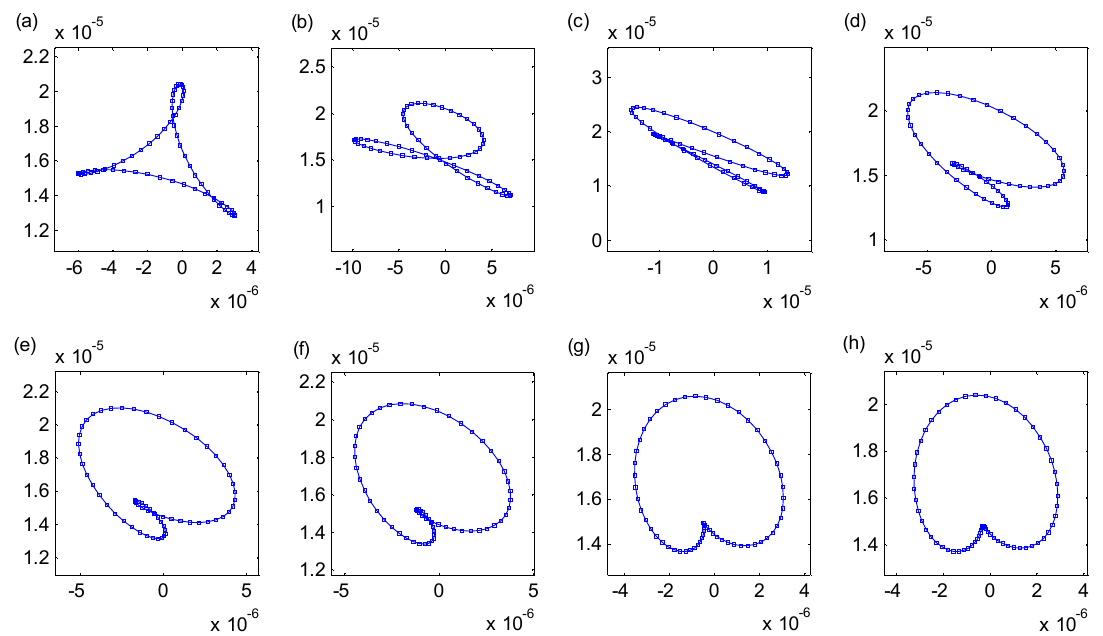
Figure 7. The evolution of orbits of the central node versus the anisotropic parameters of principle sti ff ness coe ffi cient at the speed of 3800 r / min: ( a ) α k = 0.5; ( b ) α k = 0.6; ( c ) α k = 0.7; ( d ) α k = 0.8; ( e ) α = 0.9; ( f ) α = 1.0; ( g ) α = 1.5; ( h ) α =